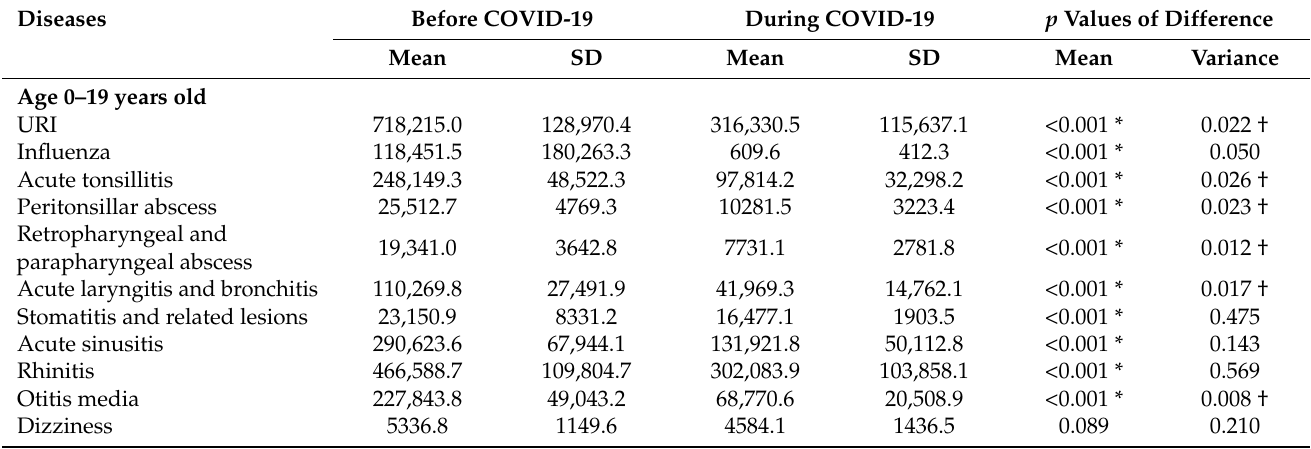
Table 3. Mean and standard deviation of the incidence of diseases before and during COVID-19 and their differences in the subgroups relative to